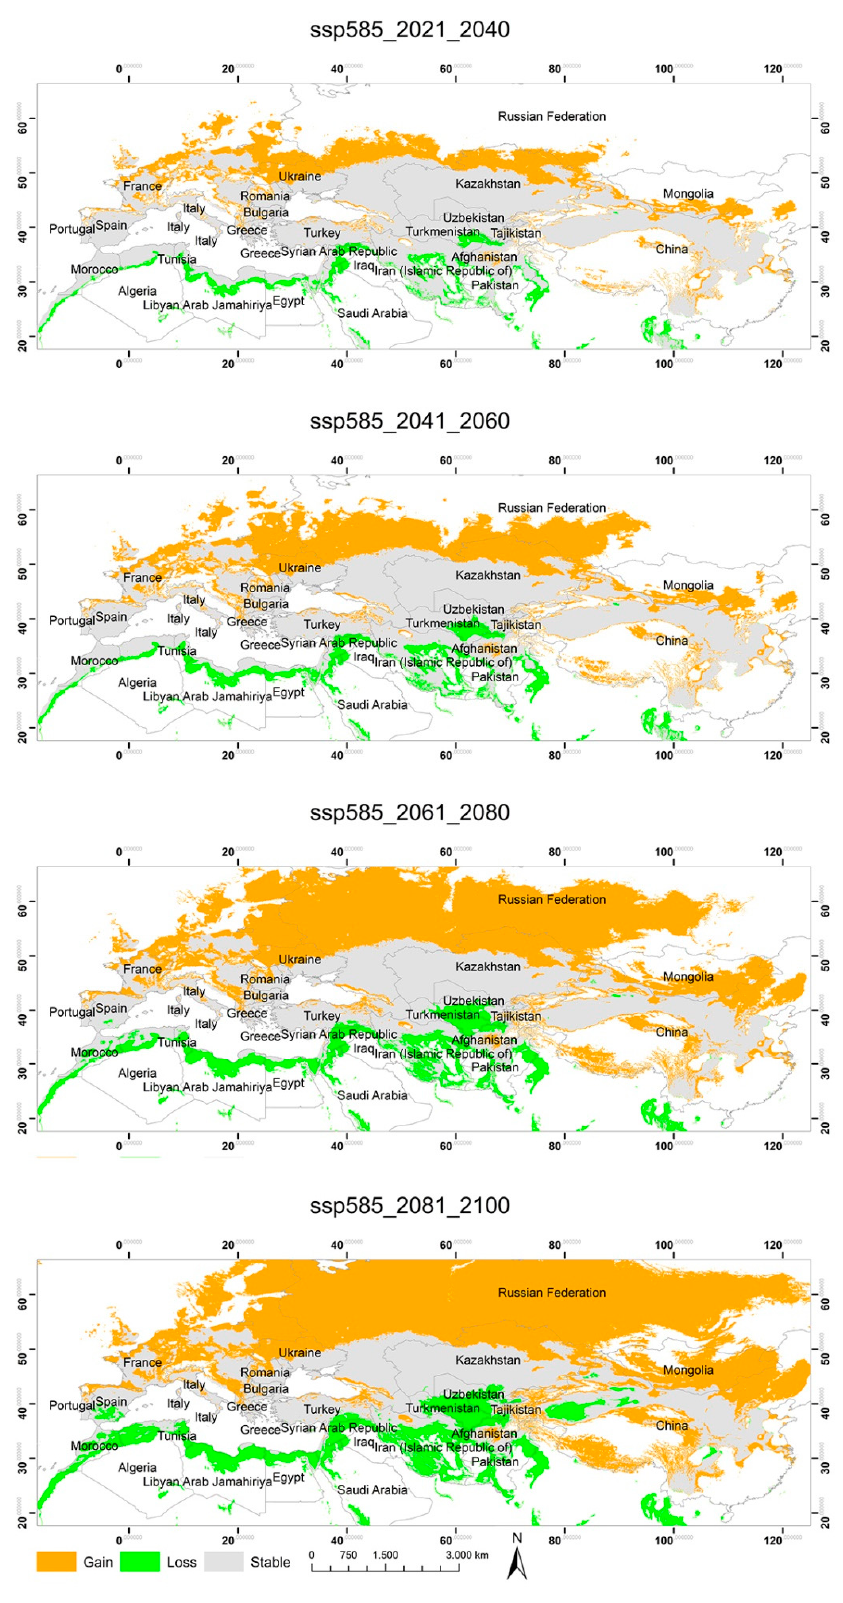
Figure A1. Habitat suitability (loss, stable, gain) of stranglewort for three scenarios.